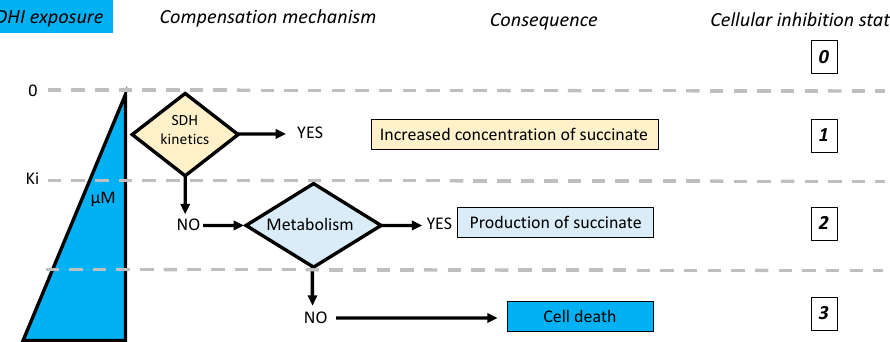
Figure 11. Adaptive responses to increasing levels of inhibition of the SDH. The limit between state 1 (kinetic response) and state 2 (metabolic response) is based on the assumption that inhibition of half or more of the SDH activity would require metabolic compensation with continuous 1/1 replenishment of oxaloacetate in TCA (Supplementary Materials S1, Figure S3). Too low levels or ablation of SDH activity might be tolerated by some cells but not by others (state 3), leading to cell death.